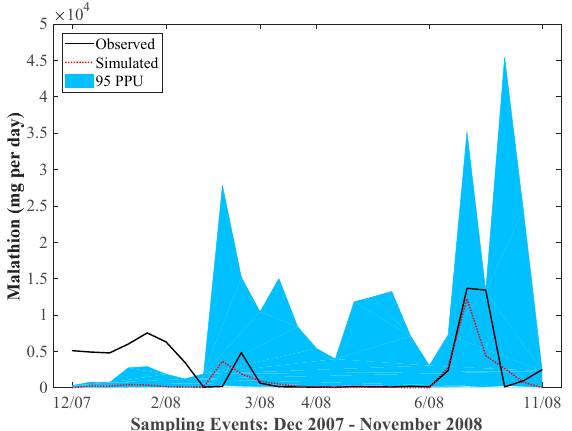
Figure 6. Observed and simulated malathion concentrations at Lucban Station over the calibration (December 2007–November 2008) period together with the 95% uncertainty band (95 PPU).